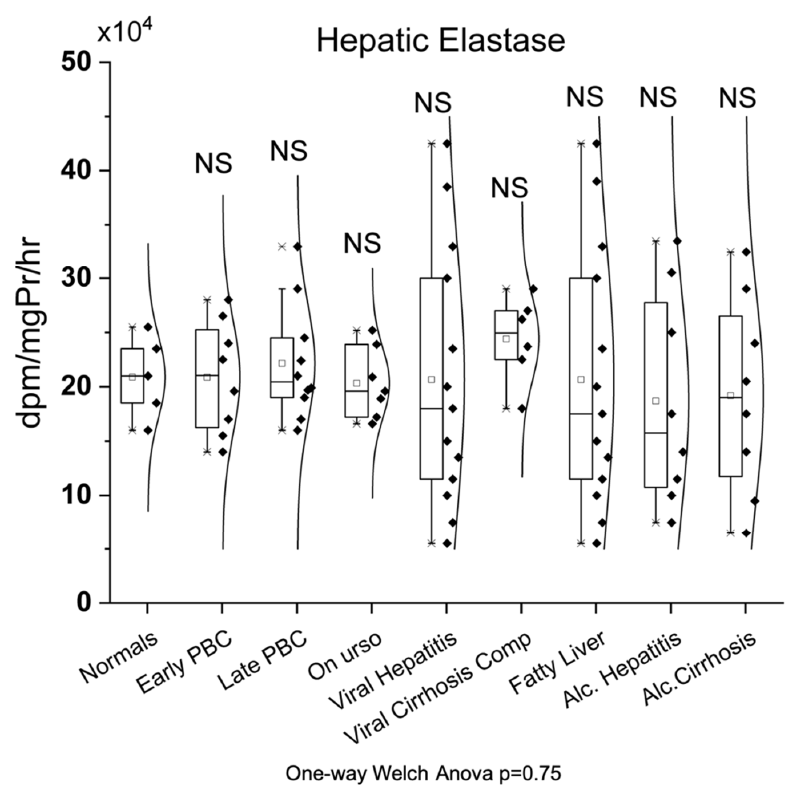
Figure 5. Enzymatic activity of hepatic elastase in all studied groups.